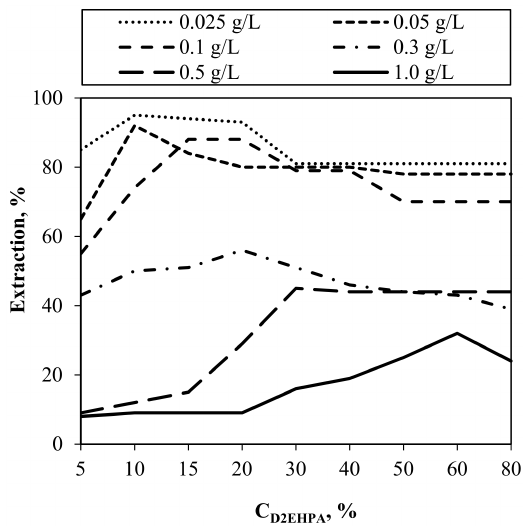
Figure 1. Extraction percentage depending on the D2EHPA concentration in membrane phase and Cr(III) ion concentration in the feed